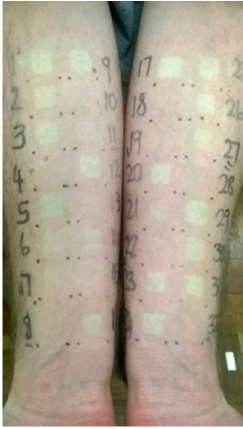
Figure 1. Typical blanching responses after randomized application of 0.0025 M solutions of halcinonide and clobetasol propionate (1).